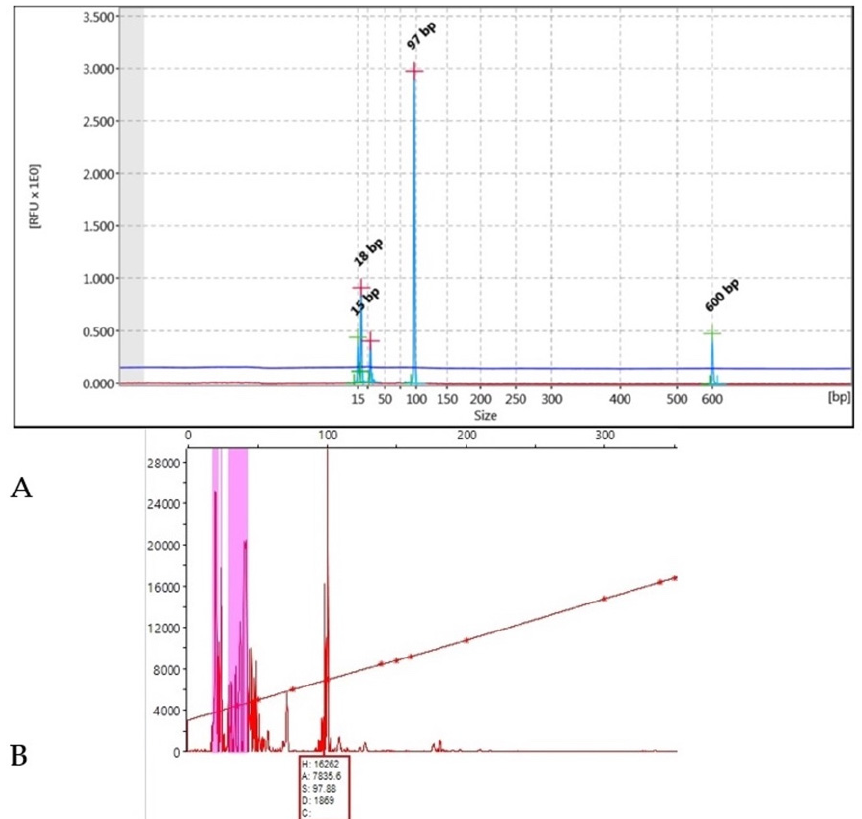
Figure 2. Homozygous sample for allele 97 bp of the G10C locus defined both by ( Α ) the QIAxcel Advanced System and ( Β ) the ABI3500 genetic analyser.